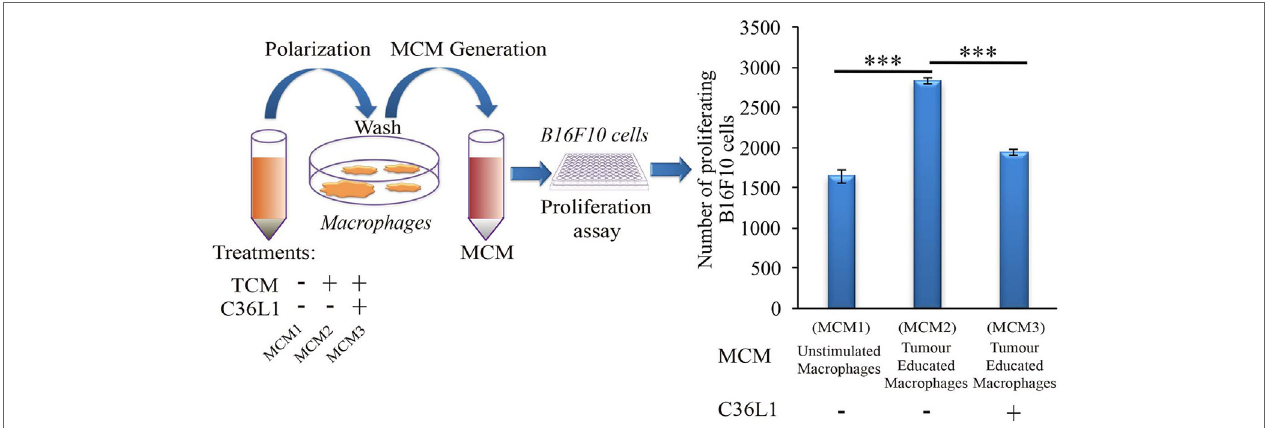
FigUre 2 | C36L1 counteracts the pro-tumorigenic activity of macrophages (MOs) induced by melanoma derived factors. Left: Schematics describing the workflow of the tumor cell proliferation assay. Tumor cells are exposed to either conditioned media from: untreated MOs (MCM1), MOs exposed to tumor-conditioned media (TCMs) from metastatic melanoma B16F10 cells (MCM2), or MOs exposed to C36L1 peptide + TCM from B16F10 cells (MCM3). Next, macrophage conditioned media (MCM) generated from these three conditions were added into B16F10 melanoma, cells and the number of live proliferating cells was quantified by flow cytometry after 72 h. Right: Bar graph represents average of three independent experiments ( n = 3). Values represent means ± SEM, and data were analyzed using a two-tailed unpaired t -test (*** p <